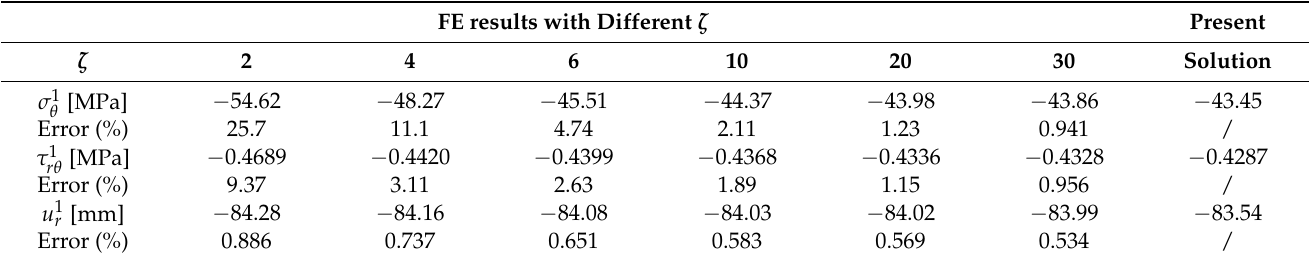
Figure 5. Schematic diagram of the FE model of 1/4 part of the pipe. Table 2. The results of comparison between the present solution and the FE solution. FE results with Different ζ